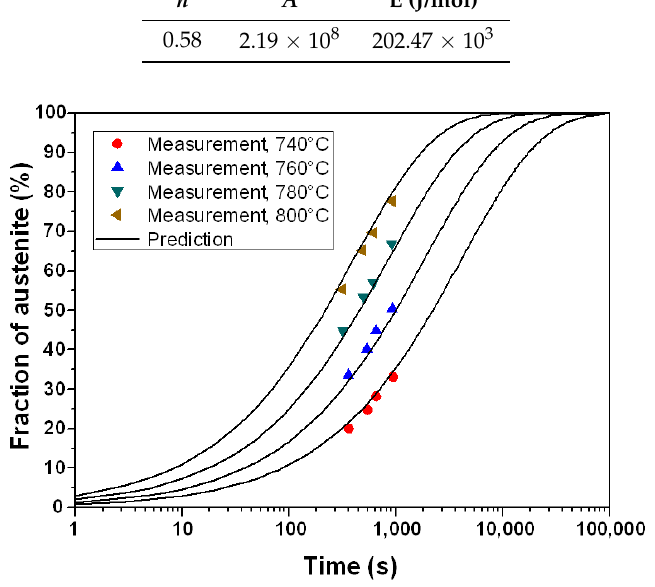
Figure 2. Comparison of the austenite fraction between the measurement and prediction.